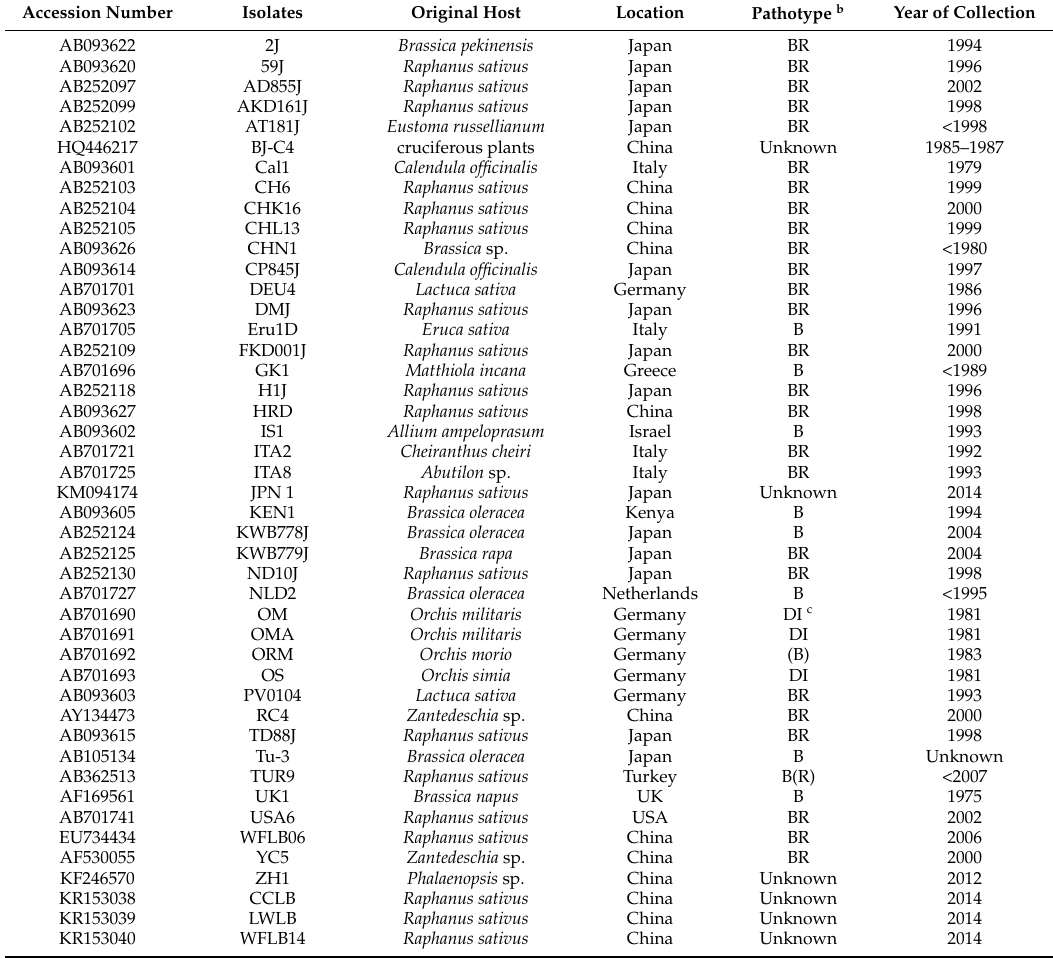
Table 3. TuMV isolates analyzed in this study a